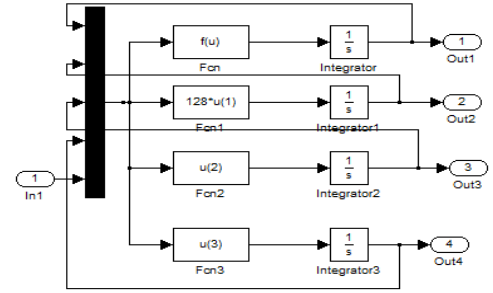
Fig 4. Applying the optimal LQR control method for the system G(s).